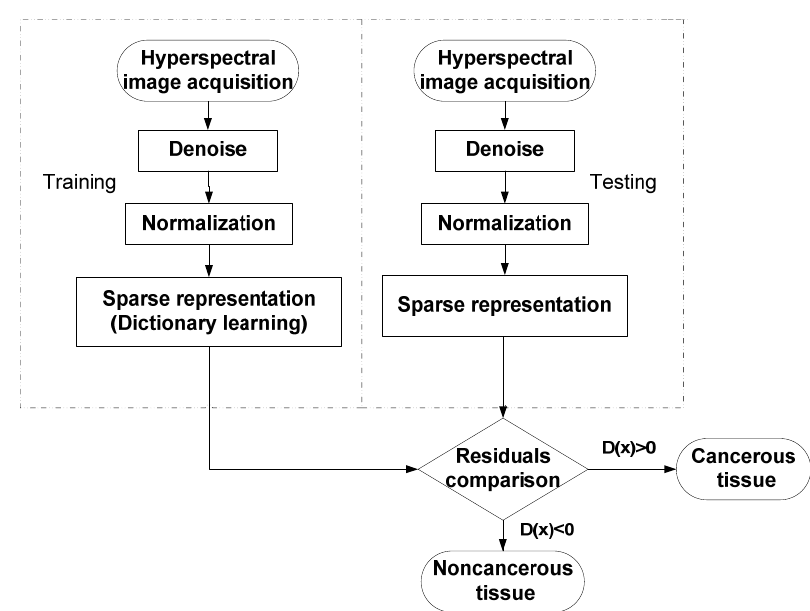
Figure 3. Flowchart of the